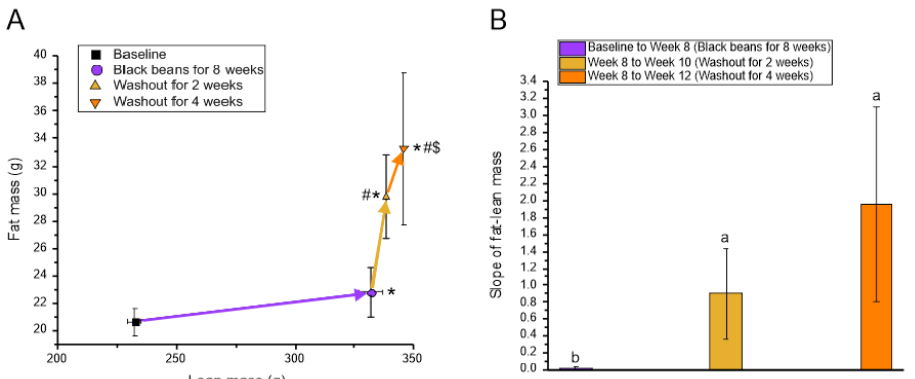
Figure 4. Phase 2: Whole body fat mass and lean mass of SHR. ( A ) Whole body fat-lean mass relationships from baseline to week 8, week 8 to week 10, and week 10 to week 12; ( B ) Slope of whole body fat-lean mass relationships. Measurements were obtained in vivo using an EchoMRI whole body quantitative magnetic resonance instrument. In Panel A, arrows between time points indicate direction of change. Data are expressed as mean ± SEM ( n = 4–9 / group); some SEM bars for lean mass are too small to be visible in the figure. * , lean mass significantly di ff erent ( p < 0.05) from baseline; # , fat mass significantly di ff erent ( p < 0.05) from baseline; $ , fat mass significantly di ff erent ( p < 0.05) from week 8. In Panel B, di ff erent letters represent significant di ff erences ( p < 0.05). Abbreviations: SHR, spontaneously hypertensive rats.